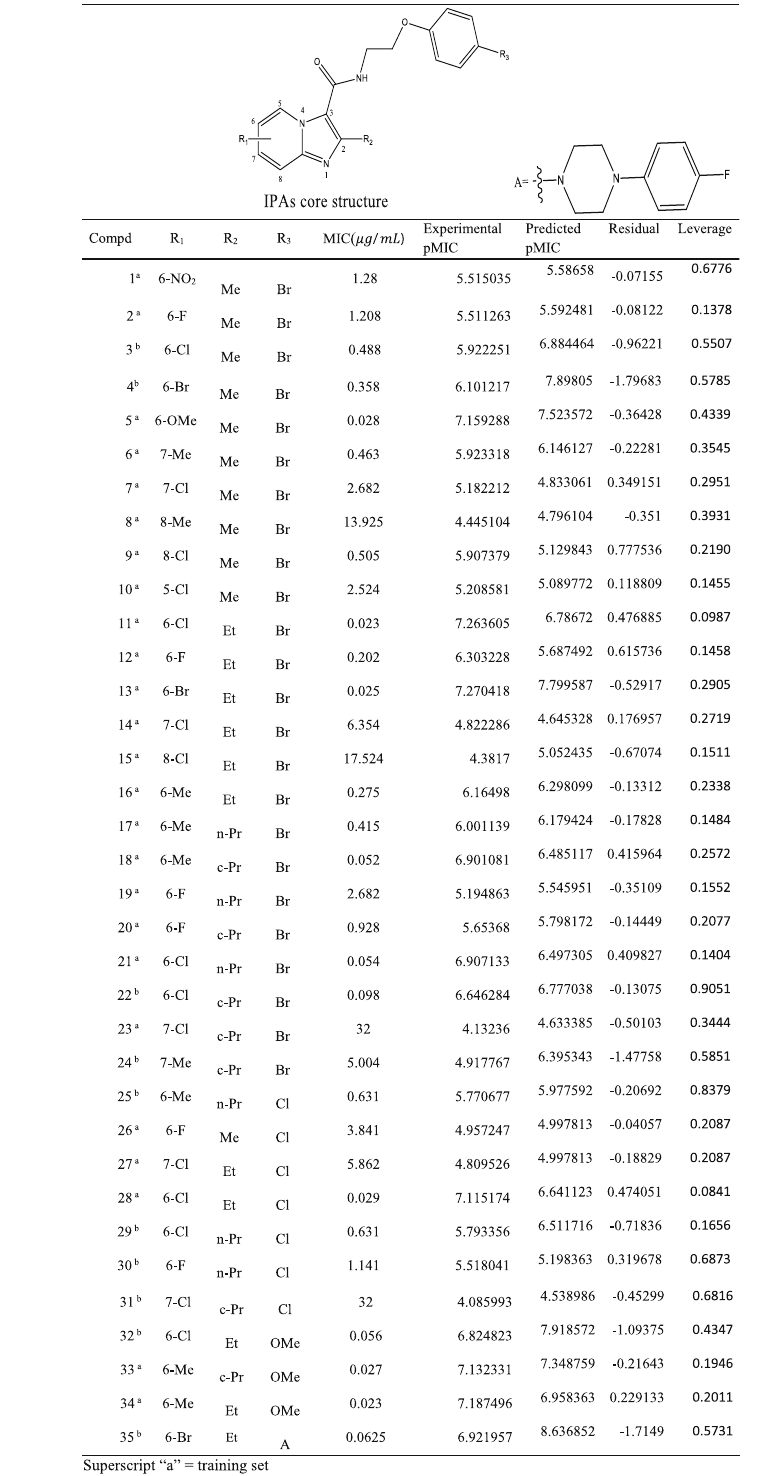
a Training set b Test